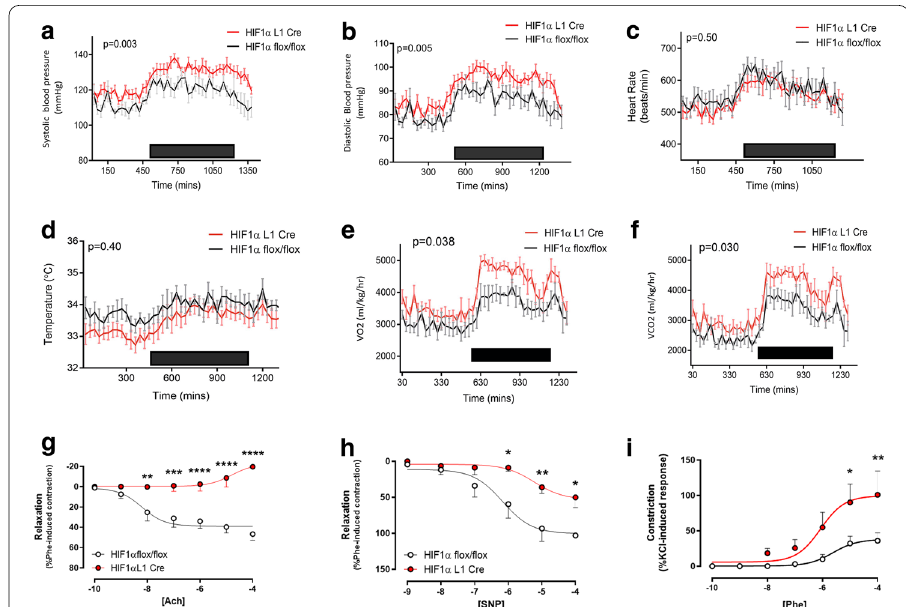
Fig. 3 Effects of HIF-1α pulmonary endothelial knockout on constitutive cardiovascular function. Circadian variations in a systolic, b diastolic blood pressure, c heart rate, d subcutaneous temperature, e VO 2 and f VCO 2 of HIF-1α L1 Cre (red, n 11) and littermate HIF-1α flox/flox (grey, n 9) mice were recorded by = = radio-telemetry. Black box represents nocturnal phase. Data are presented as a mean SEM for each 30 min ± period, p value for area under the curve followed by unpaired t test are shown. Femoral artery reactivity was assessed using wire myography in HIF-1α L1Cre (red, n 5) and HIF-1α flox/flox littermates (grey, = n 5). g Degree of relaxation was expressed as a percentage of the contraction induced by phenylephrine. = [ACh]: molar concentration of acetylcholine. h Degree of relaxation was expressed as a percentage of the contraction induced by phenylephrine. [SNP]: molar concentration of sodium nitroprusside and i degree of vasoconstriction developed in response to increasing molar concentrations of phenylephrine ([Phe] 10 − 5 M). Data presented as Mean SEM for concentration response, analysis by two-way ANOVA (* p < 0.05, ** p < 0.01, ± *** p <